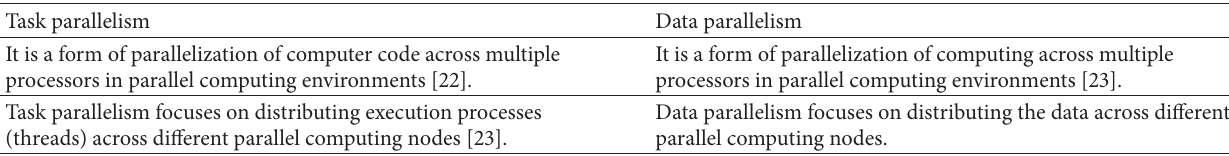
Table 1: Comparison between task parallelism and data parallelism. Task